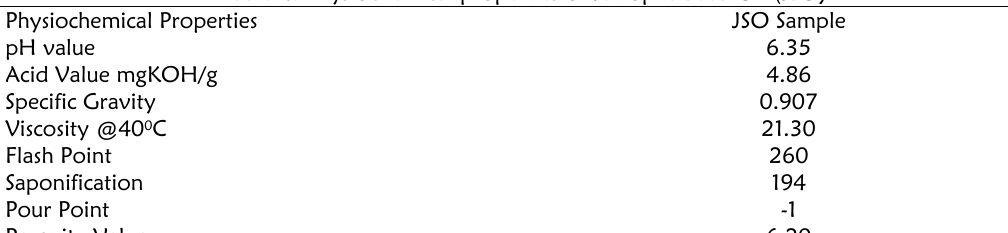
Table 4: Physiochemical properties of Jatropha Seed Oil (JSO)